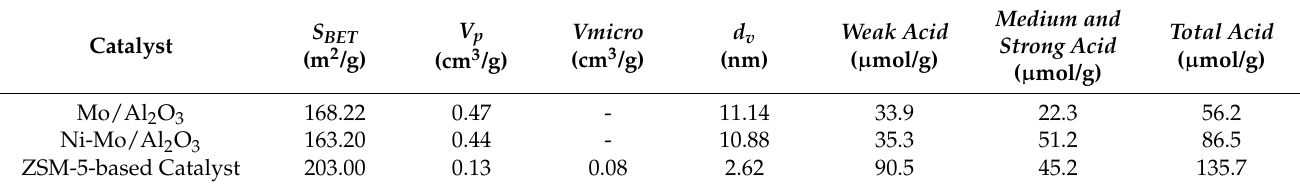
Figure 3. NH 3 -TPD of Mo/Al 2 O 3 , Ni-Mo/Al 2 O 3 Table 1. Textural properties and acid distribution of the